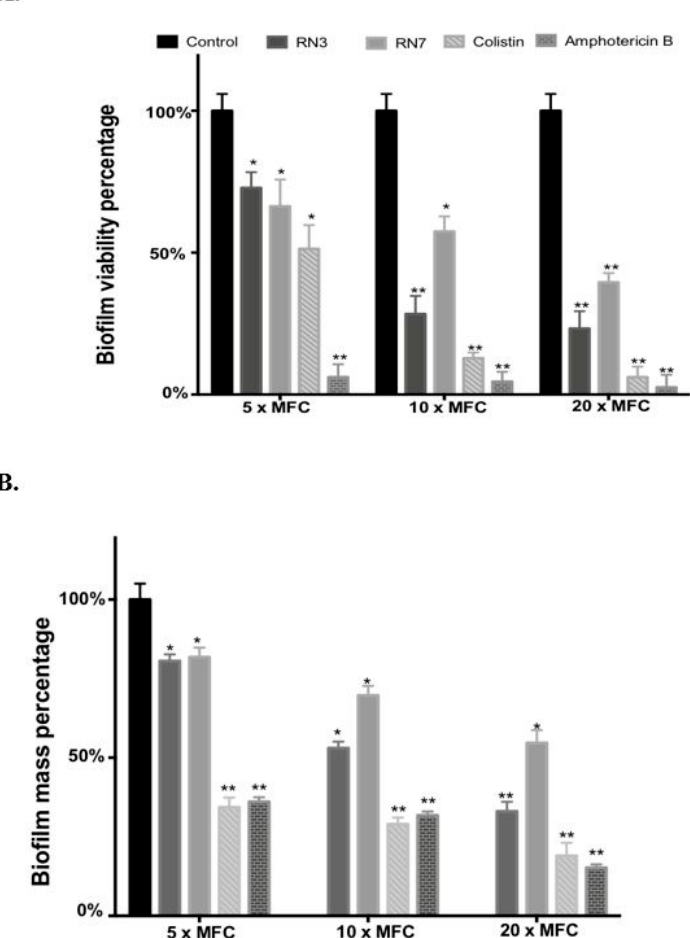
Figure 4. E ff ect of peptides (RN3 and RN7), colistin and amphotericin B on stablished C. albicans biofilms. ( A ). The viability of preformed biofilms was quantified by PrestoBlue dye after 24 h of incubation with the corresponding treatment at 5 × , 10 × and 20 × MFC (Peptide concentration 5, 10 and 20 µ M; amphotericin B 2.5, 5 and 10 µ M and colistin 1.25, 2.5 and 5 µ M). Fluorescence changes were measured at excitation / emission of 535-615 nm. ( B ) The biofilm was stained by crystal violet, then the dye was solubilized in ethanol, its absorbance measured at 570 nm and the percentage of biofilm reduction was compared to untreated wells control. All experiments were done in triplicate. Statistically significant results were evaluated by ANOVA test, followed by Dunnett’s Multiple Comparison Test (* p < 0.05 and ** p < 0.001).